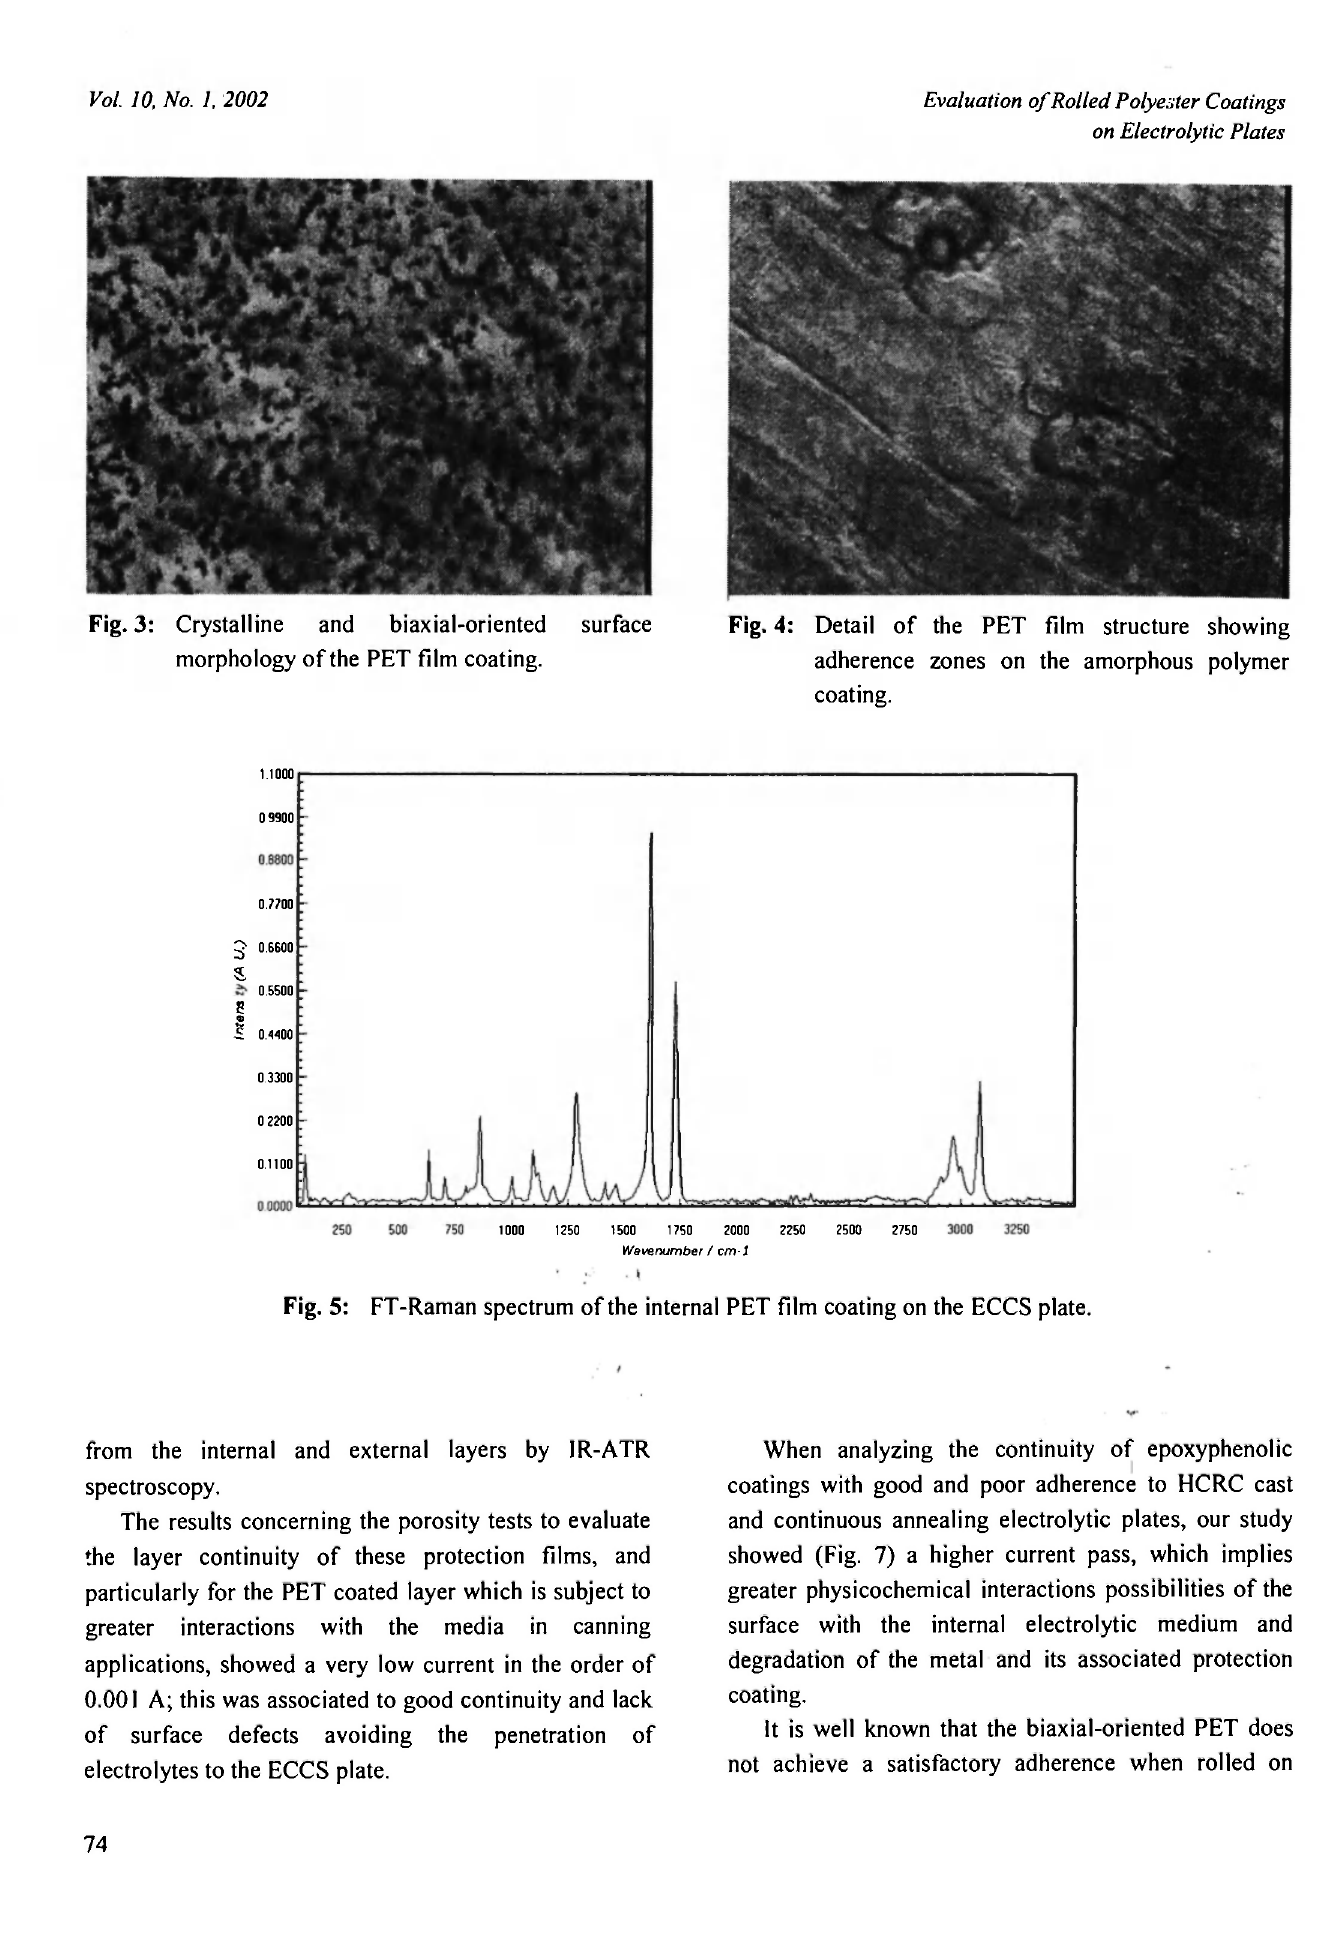
Fig. 3: Crystalline and biaxial-oriented surface morphology of the PET film coating.